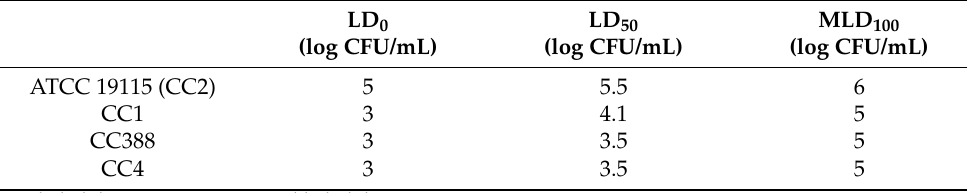
Table 1. Seven days of mortality monitoring in mice inoculated intravenously with L. monocytogenes .